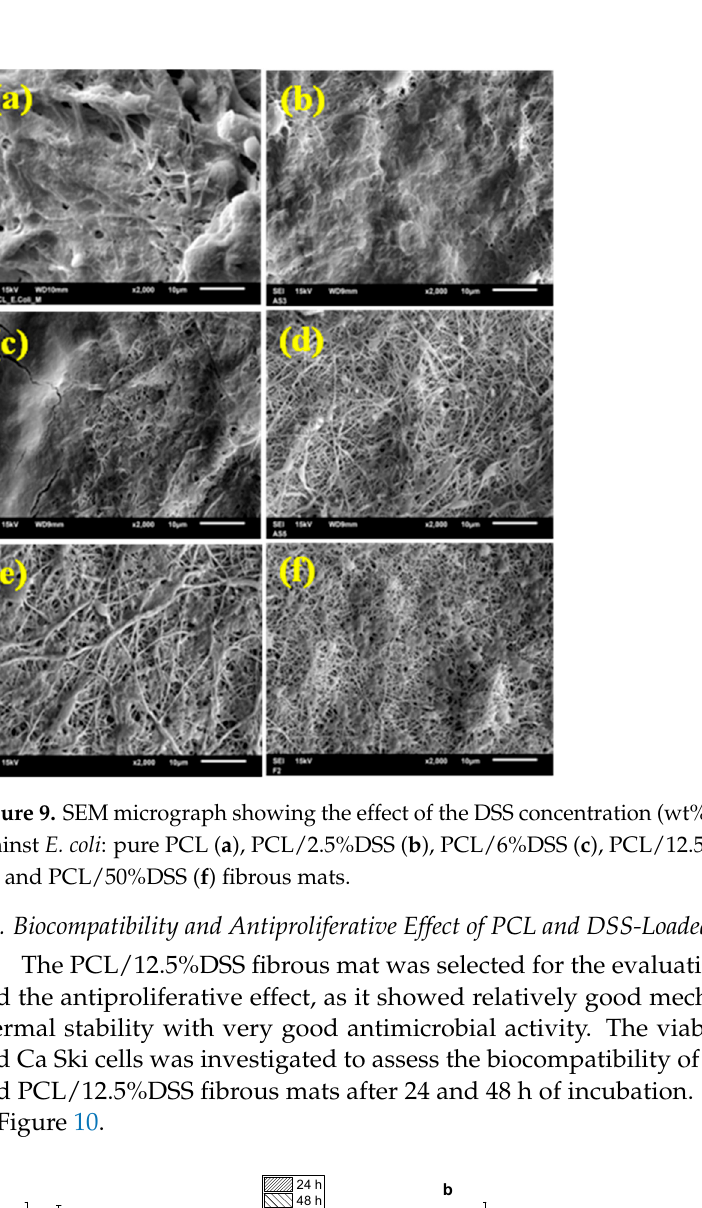
Figure 8. SEM micrograph showing the effect of the DSS concentration (wt%) on antibacterial effi- cacy against S. aureus : pure PCL ( a ), PCL/2.5%DSS ( b ), PCL/6%DSS ( c ), PCL/12.5%DSS ( d ),